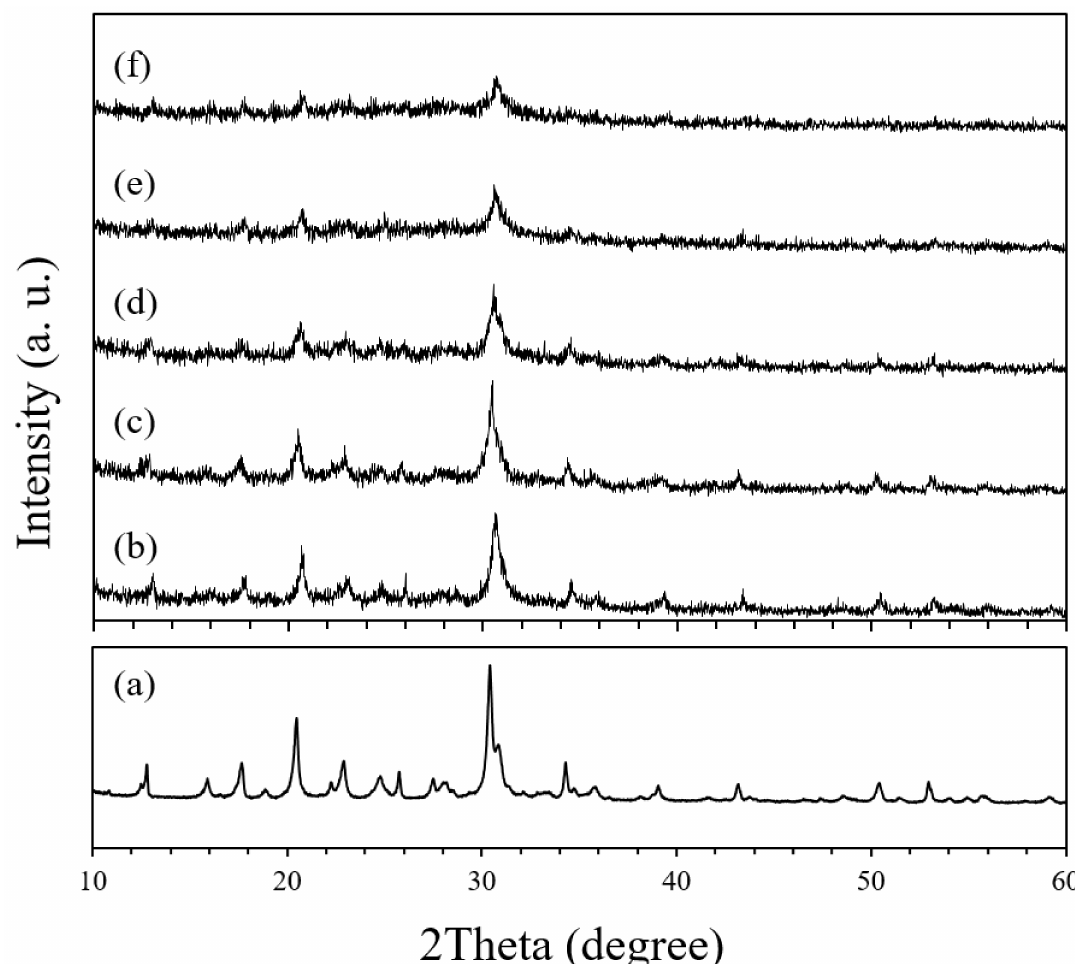
Figure 3. X-ray diffraction patterns of ( a ) original CHA zeolite particles and ( b – f ) planetary-milled S1 to S5